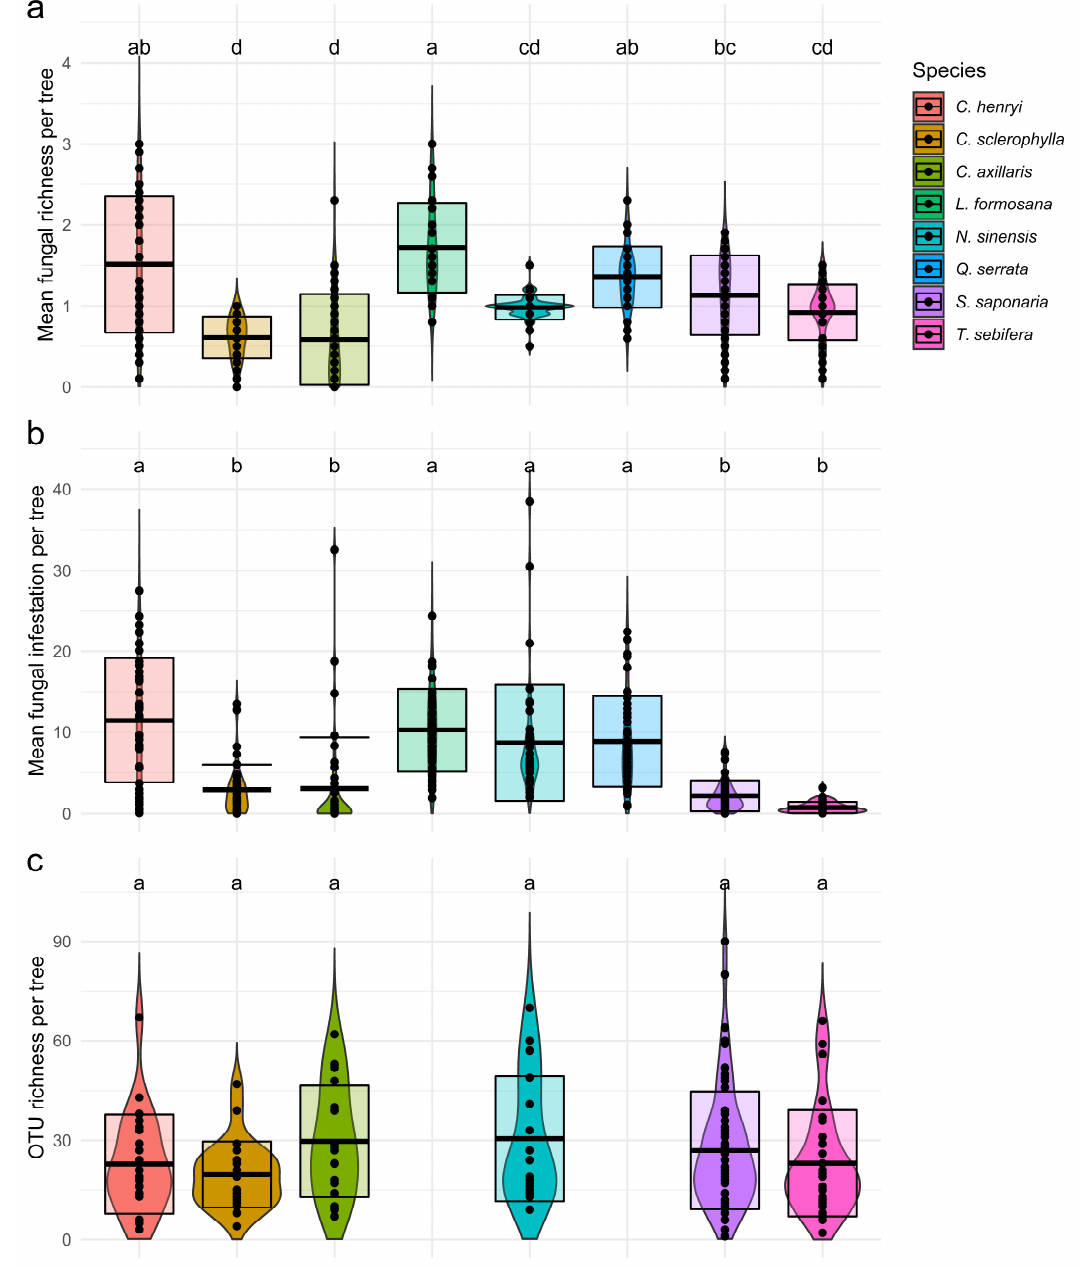
Figure 1. Difference between the eight studied tree species with respect to ( a ) mean fungal richness and ( b ) mean fungal infestation, both based on visual assessment, and ( c ) OTU richness. Letter combinations indicate significant differences between tree species according to a Tukey post-hoc test applied to the linear mixed effects model. ( a ) p < 2.2e-16, ( b ) p < 2.2e-16, ( c ) p = 0.1755.